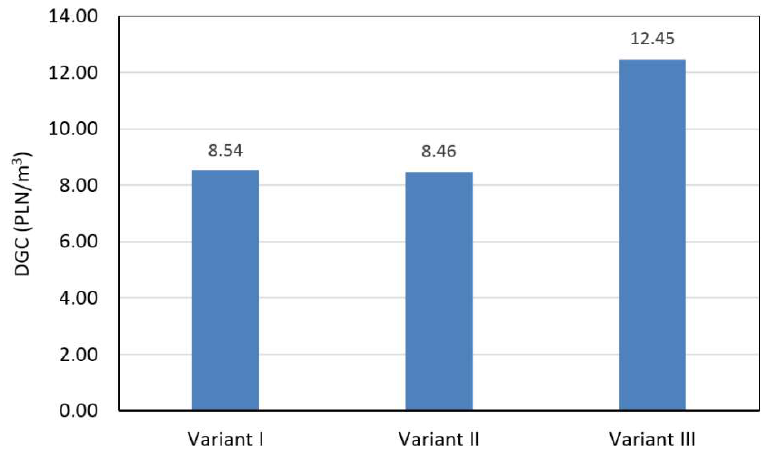
Figure 7. Determined values of dynamic generation cost indicator for three studied variants of or- ganized sewerage disposal in Zagrody.